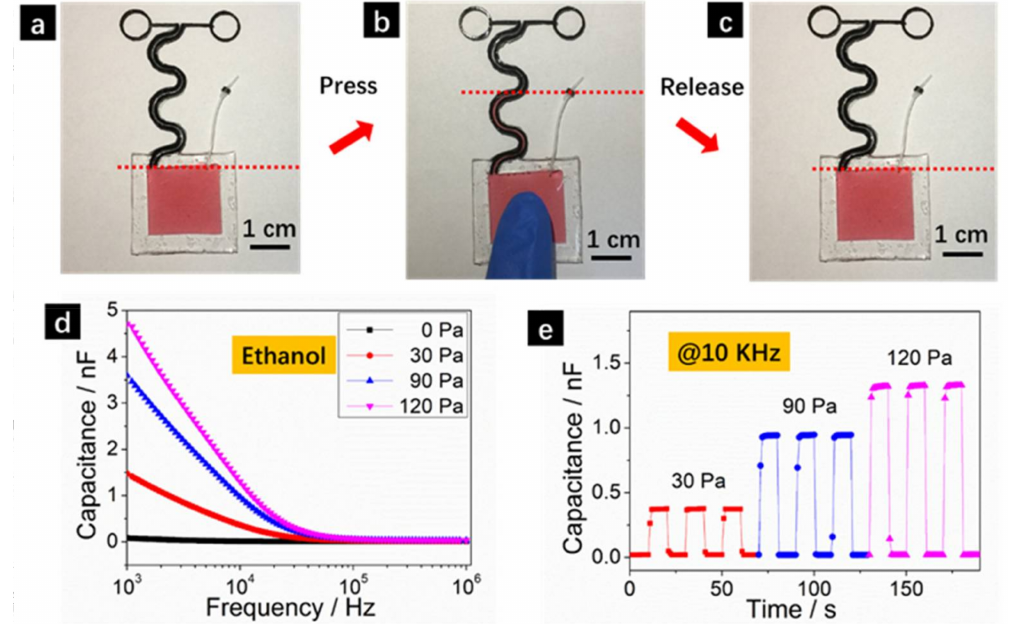
Figure 2. ( a – c ) Photographs of the pressure sensor upon pressing and releasing with dash lines indicating the liquid levels; Relationship between ( d ) capacitance-frequency and ( e ) capacitance-time at respective applied pressures; The solution medium used is ethanol (>99%) and the frequency was fixed at 10 KHz in ( e